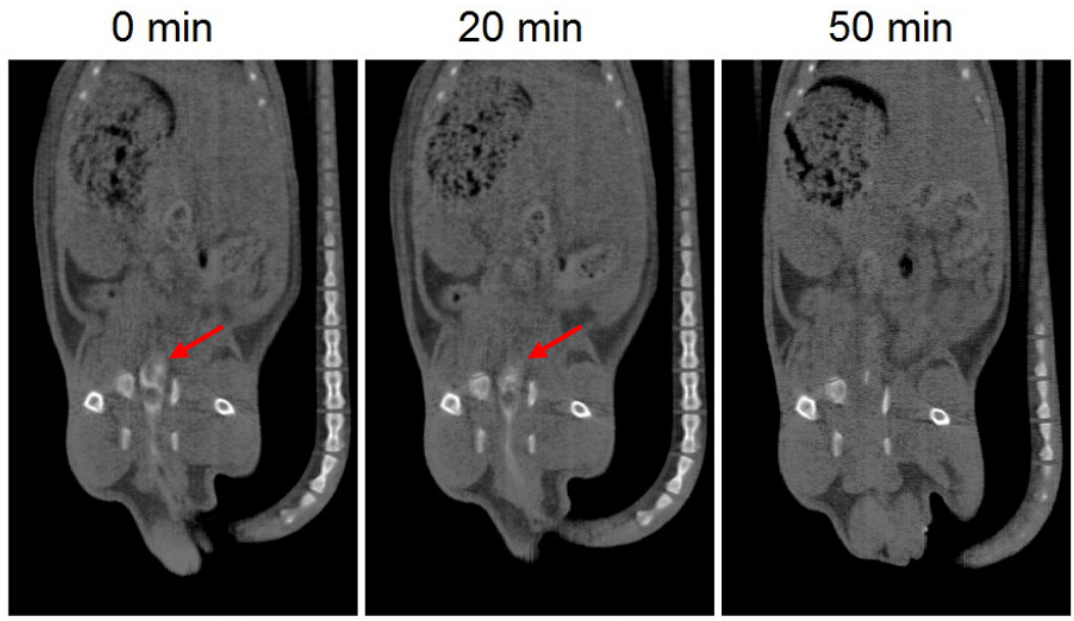
Figure 4. CT images of 3D printed suppositories with barium sulphate at different times. The red arrow indicates the location of the suppository (white color).